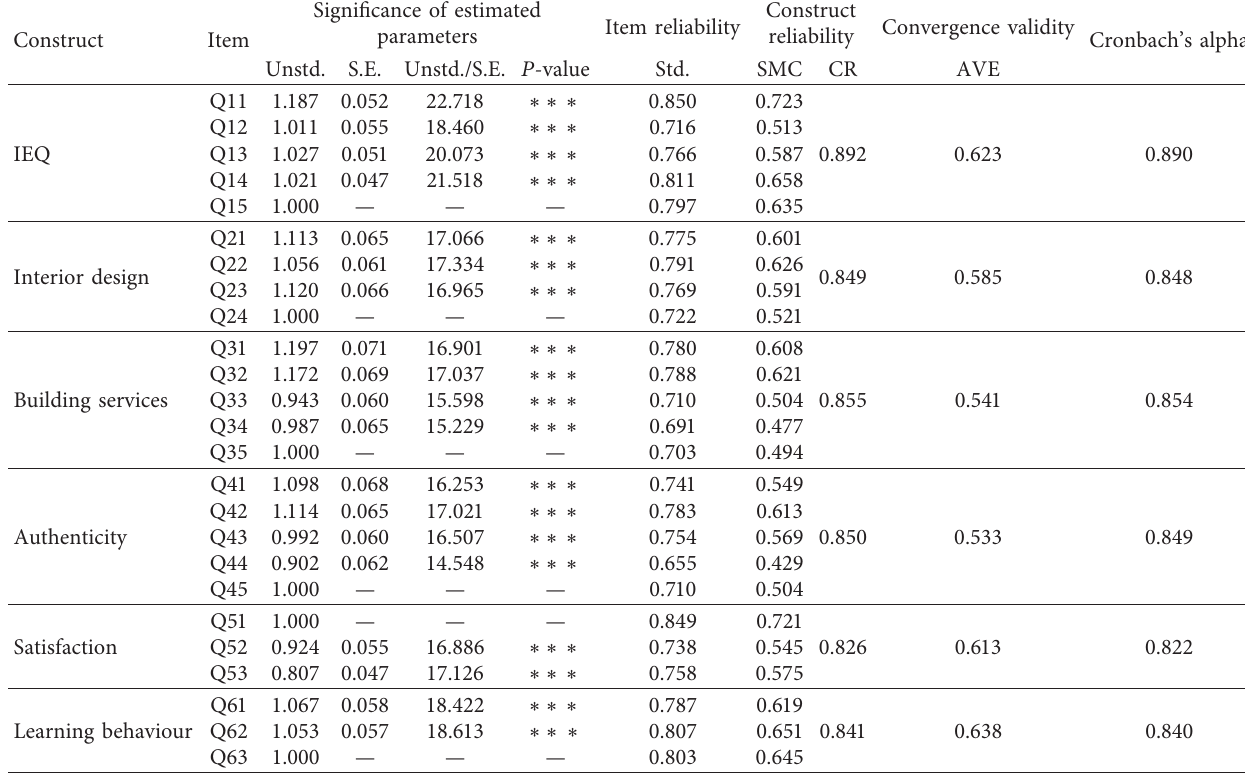
Table 5: Summary of confirmatory factor analysis.